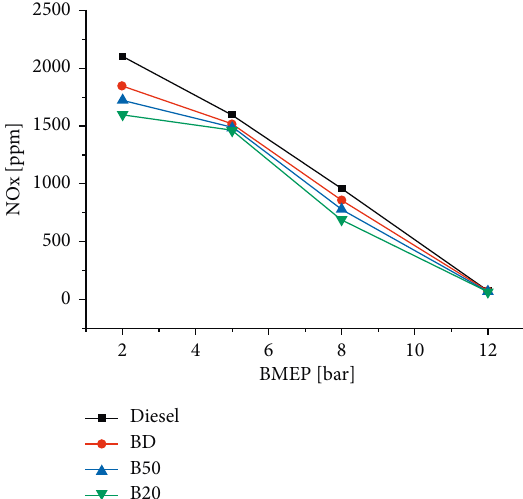
Figure 9: NOx emission with bmep @